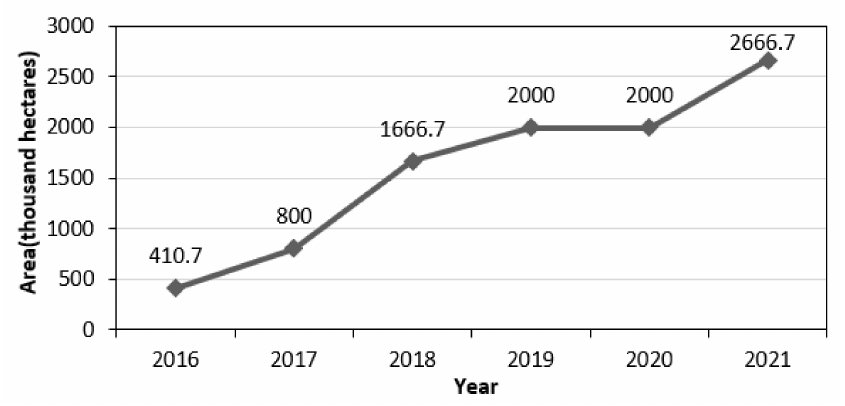
Figure 1. Area of crop rotation and fallow trials in China (Source: Key points of planting industry work in 2016–2021)